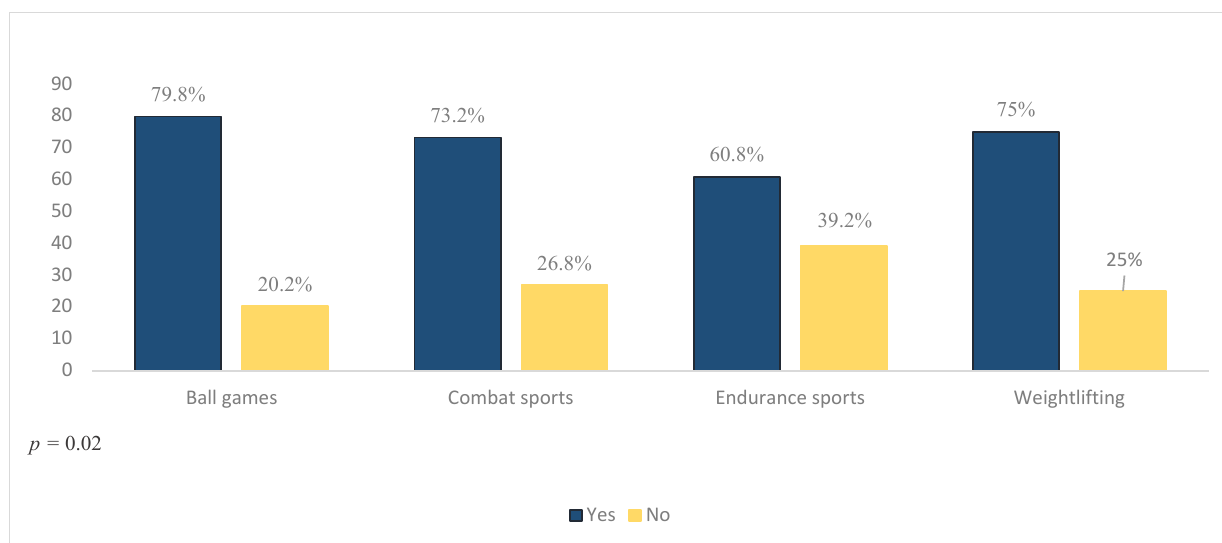
Figure 4. Overall prevalence of DSs use.